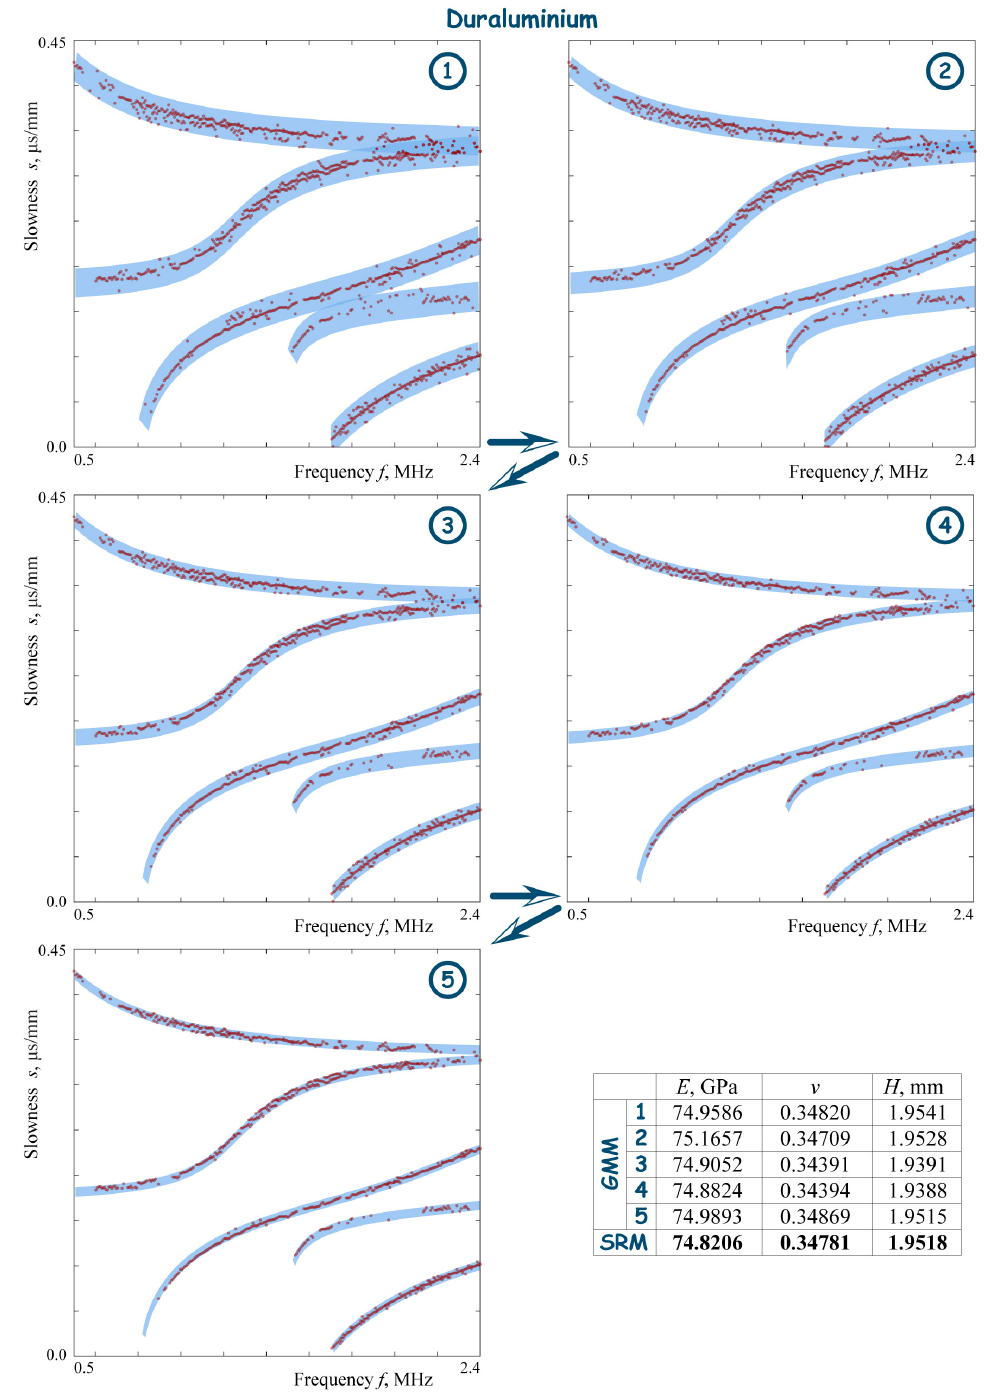
Figure 5. Experimental ˘ g ( j ) filtered during the iterative process of Step 2 for duraluminium plate with the mass density ρ = 2721 kg/m 3 and thickness H = 1.9